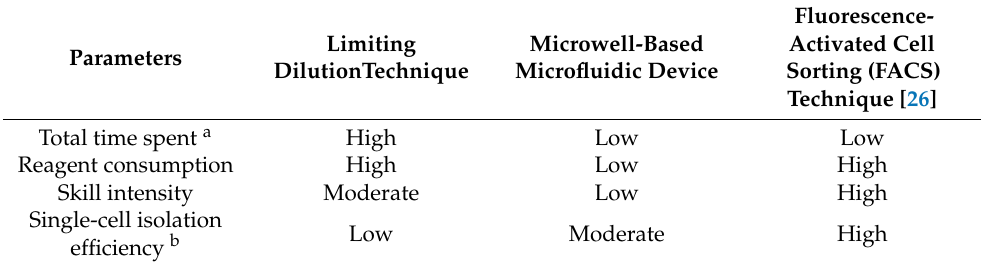
Table 1. Comparison of single-cell cloning using the MBM device, the limiting dilution technique, and the Fluorescence-Activated Cell Sorting (FACS) technique. Fluorescence- Activated Cell Limiting Microwell-Based Parameters Sorting (FACS) DilutionTechnique Microfluidic Device Technique [26] Total time spent a High Low Low Reagent consumption High Low High Skill intensity Moderate Low High Single-cell isolation Low Moderate High efficiency b